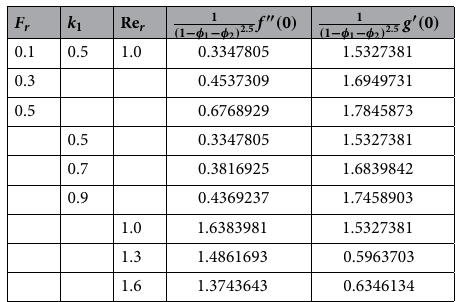
Table 2. Different physical variables have an impact on skin friction, [ Re r ]